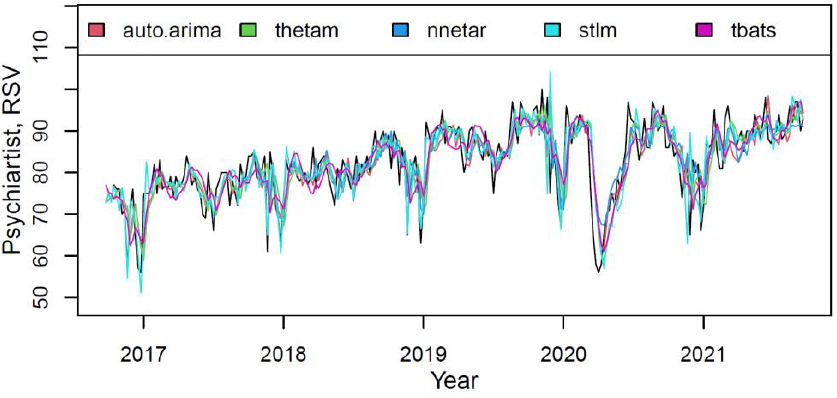
Figure 9. The actual (black) and fitted values of each component of the M3 hybrid model.